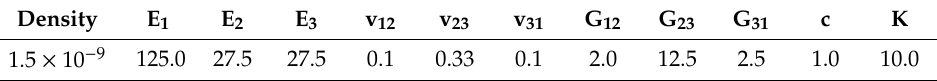
Table 2. Meniscus material properties used for FEA. E 1,2,3 : Youngs Modulus E 1 , E 2 , E 3 ; v 12 , v 23 , v 31 : Poisson’s ratio v 12 , v 23 , v 31 ; G 12 , G 23 , G 31 : shear modulus G 12, 23, 31 ; c: coe ffi cient; K: bulk modulus. Density in tons / mm 3 , other units, if defined, in MPa (Mega Pascal). K and c are without e ff ect for material behavior and served initial